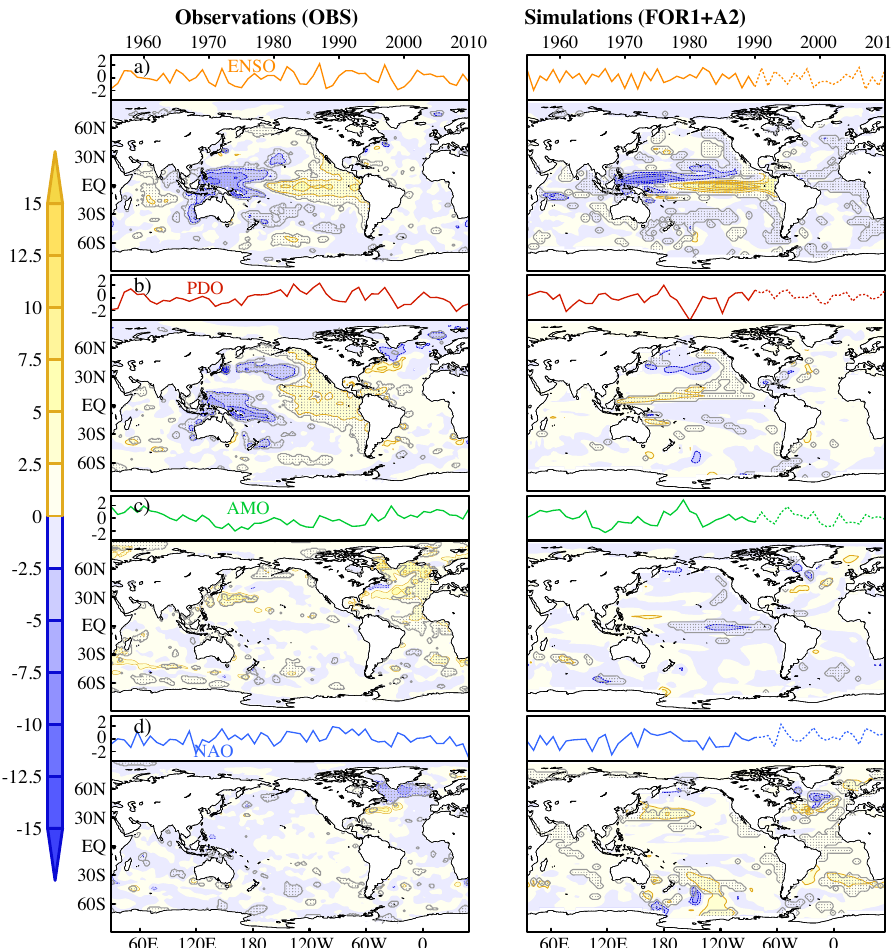
Fig. 12. Top: observed (left) and simulated (right) standardised indices of: (a) El Ni˜no 3.4; (b) PDO; (c) AMO; (d) NAO. See text for details on the particular definitions applied. Dashed lines correspond to projections in the A2 scenario run. Bottom: regression patterns between the anomalies of OHC700 (in 10 8 Jm − 2 ) and the indices above. Significance is addressed as in Fig.